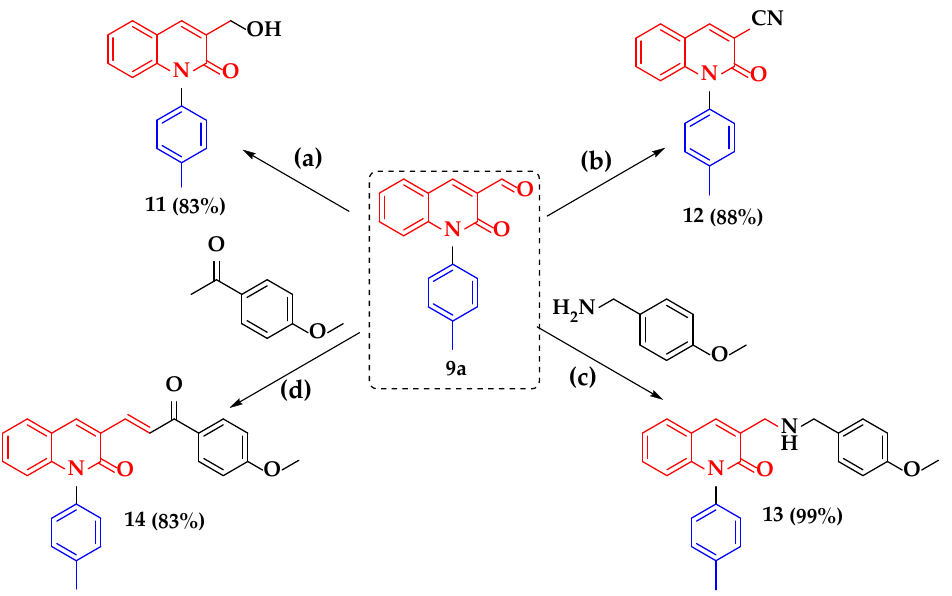
Scheme 3. Derivatization of N-p -methylphenyl-3-formylquinolone. Conditions ( a ) 9a (0.3 mmol), MeOH (4.5 mL), NaBH 4 (0.9 mmol). ( b ) 9a (0.3 mmol), hydroxylammonium chloride (0.36 mmol) and DMSO (2.5 mL), 110 ◦ C, 90 min. in mono-wave reactor. ( c ) 9a (0.3 mmol), p -methoxybenzylamine (0.32 mmol) in MeOH (1.2 mL), 4 h, rt. 2. NaBH 4 (0.48 mmol), 20 min. ( d ) 9a (0.3